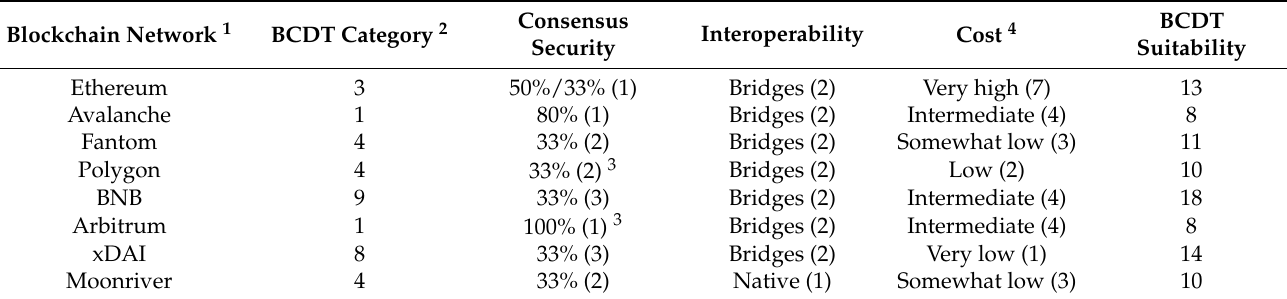
Table 7. Comparison of the public blockchain use cases in relation to key NFRs for